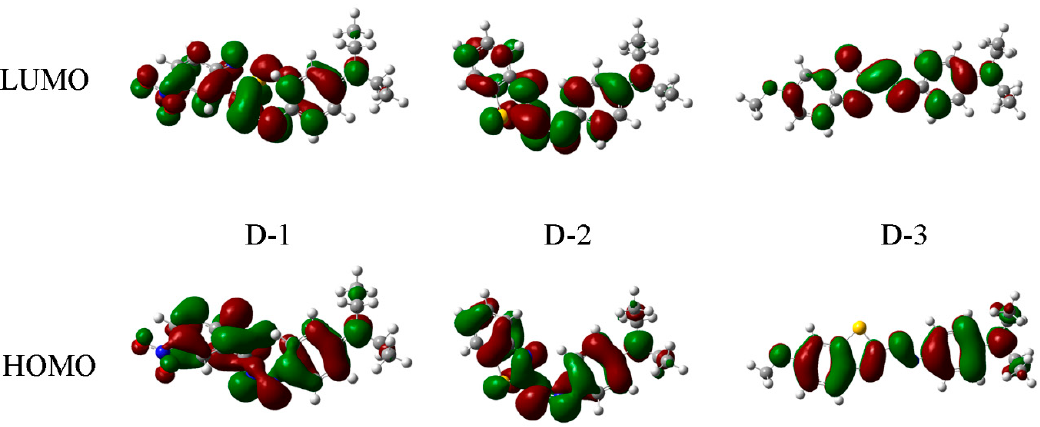
Figure 5. The HOMOs and LUMOs for dyes’ chromophores with DFT/B3LYP 6–31 G (d) basis.